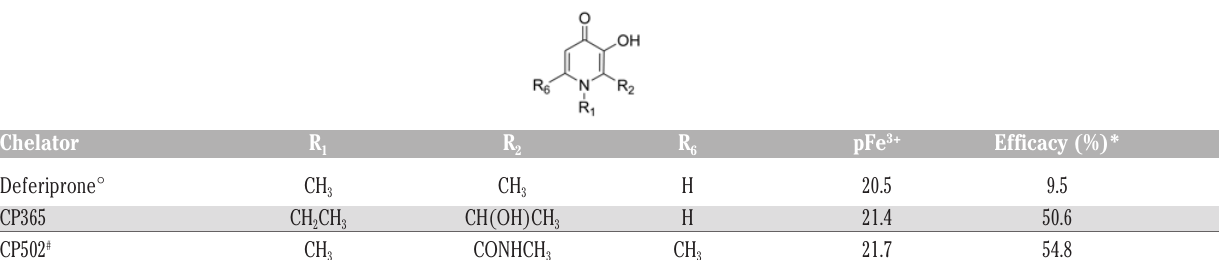
Table 2. Efficacy of 3-hydroxypyridin-4-ones.